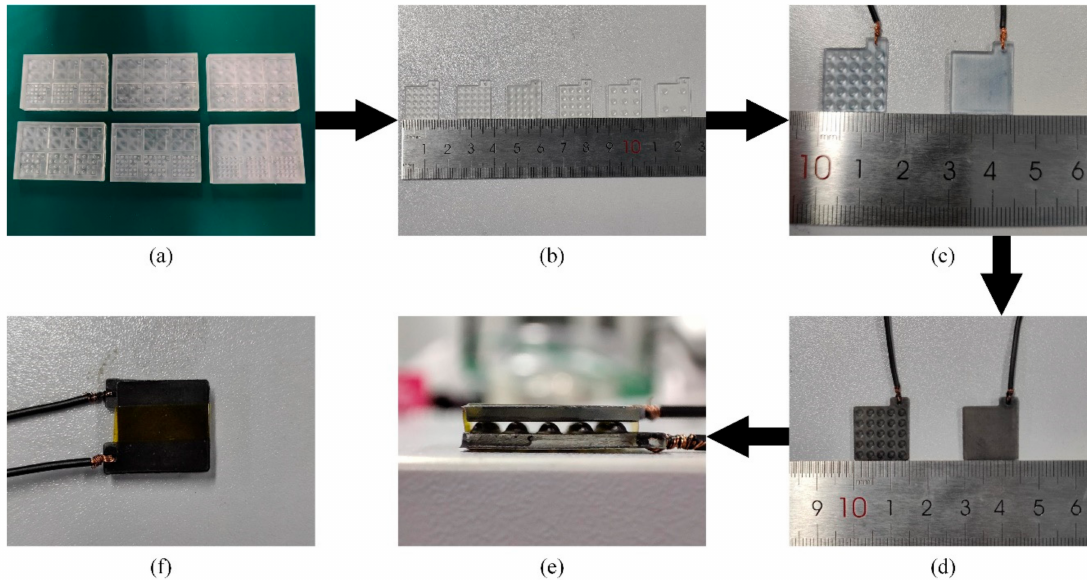
Figure 6. The fabrication process of sensors: ( a ) Template printing; ( b ) Template after cleaning and curing; ( c ) Top and bottom plates; ( d ) Plates with film electrodes; ( e , f ) Assembled